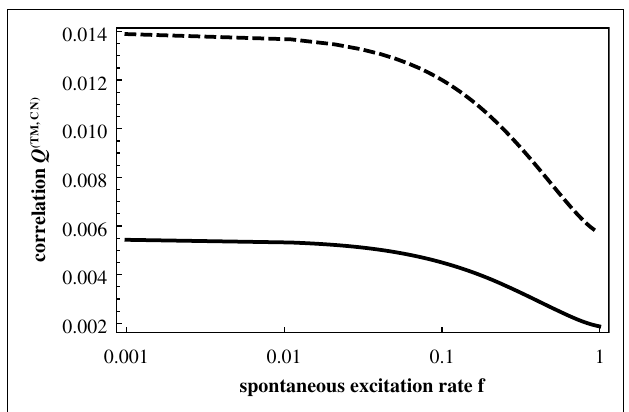
FIGURE 6 | Q (CN) (from Eq. 10; dashed curve) and Q (TM) (from Eq. 11; full curve) as a function of f